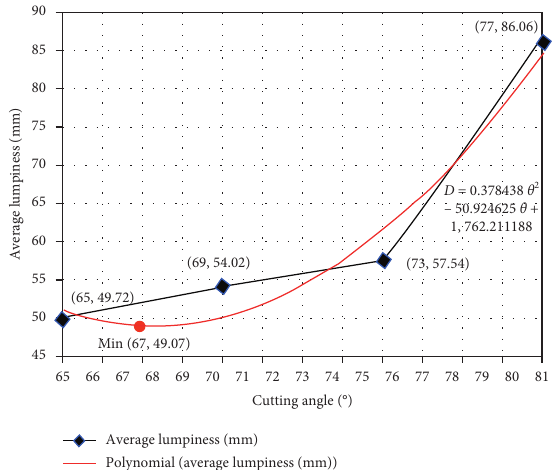
Figure 18: Fitting curves of wedge cutting model and blasting fragments at different